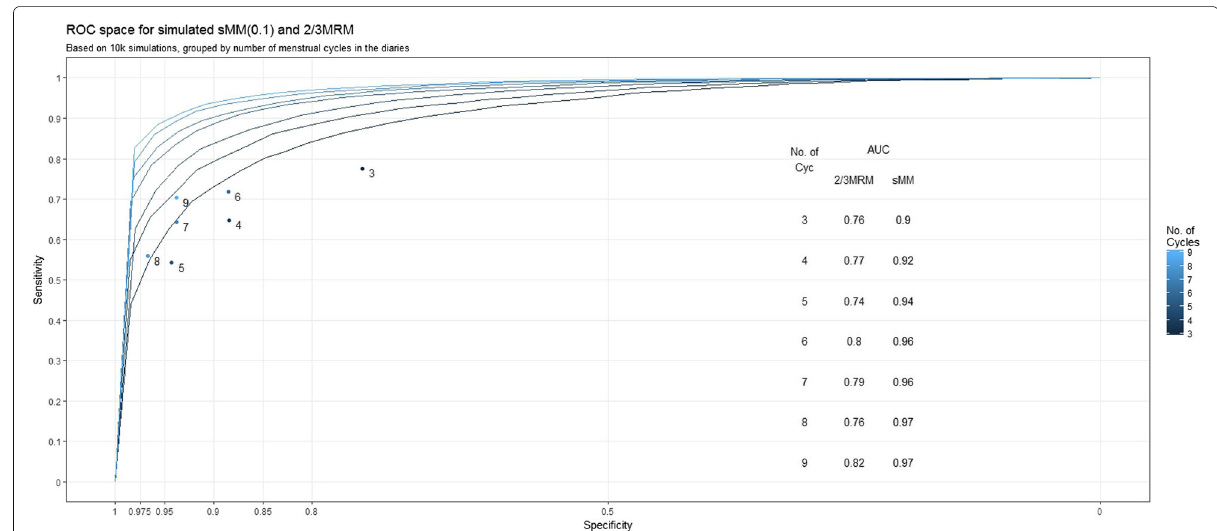
Fig. 7 ROC curve plot with AUC scores. Lighter color represents higher number of menstrual windows – i.e. longer headache diaries – in the underlying simulation. Each of the 2 × 7 (sensitivity and specificity for 3, ... ,9 cycles) simulations ran on 10 000